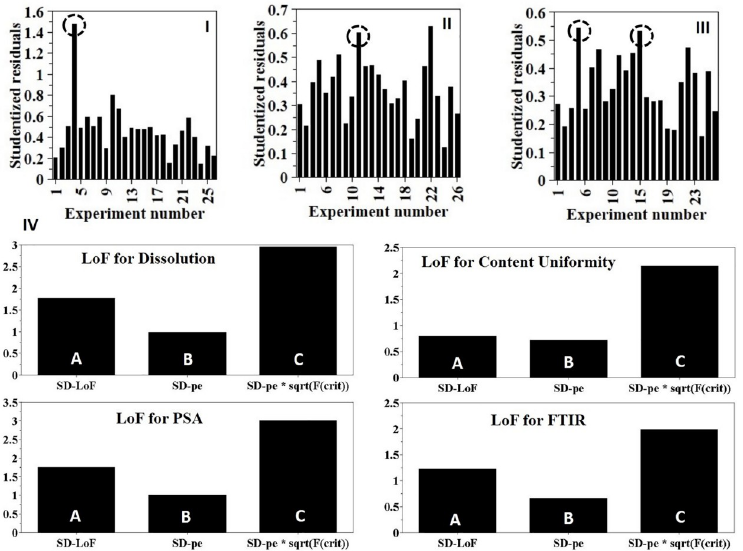
Fig 5. (I,II &III) Distance to model (Y) plot of individual runs to identify insignificant runs (highlighted with circles). Note that the distance to model changes upon removal of the furthest run. (IV) Lack of Fit plot showing standard deviation (SD) due to lack of fit (A), SD of pure error (B) and SD of pure error � critical F-value (C) for the four responses. If A � C, the model shows no lack of